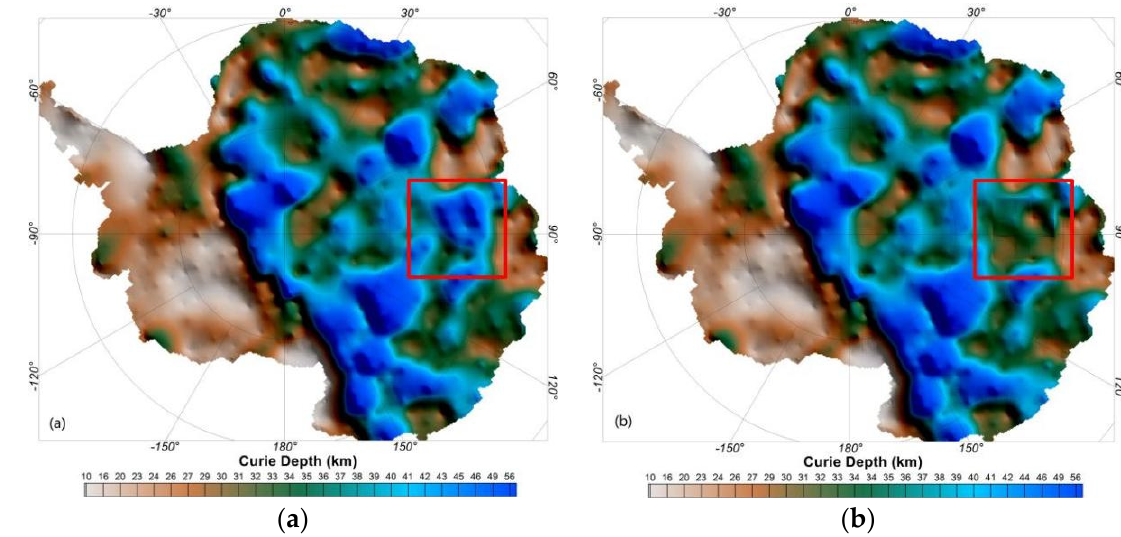
Figure 6. Comparison of Curie depth maps. The ( a ) previous calculation results of all Antarctica [1]; and ( b ) combining our calculation results in PEL (red frame area).